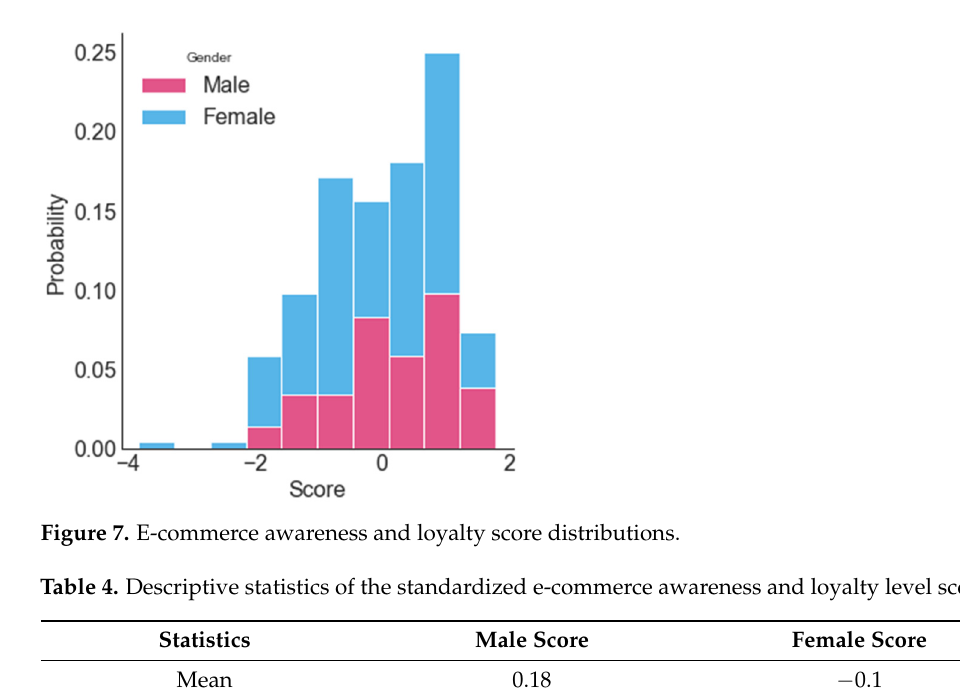
Figure 6. E-commerce awareness and loyalty score distributions.